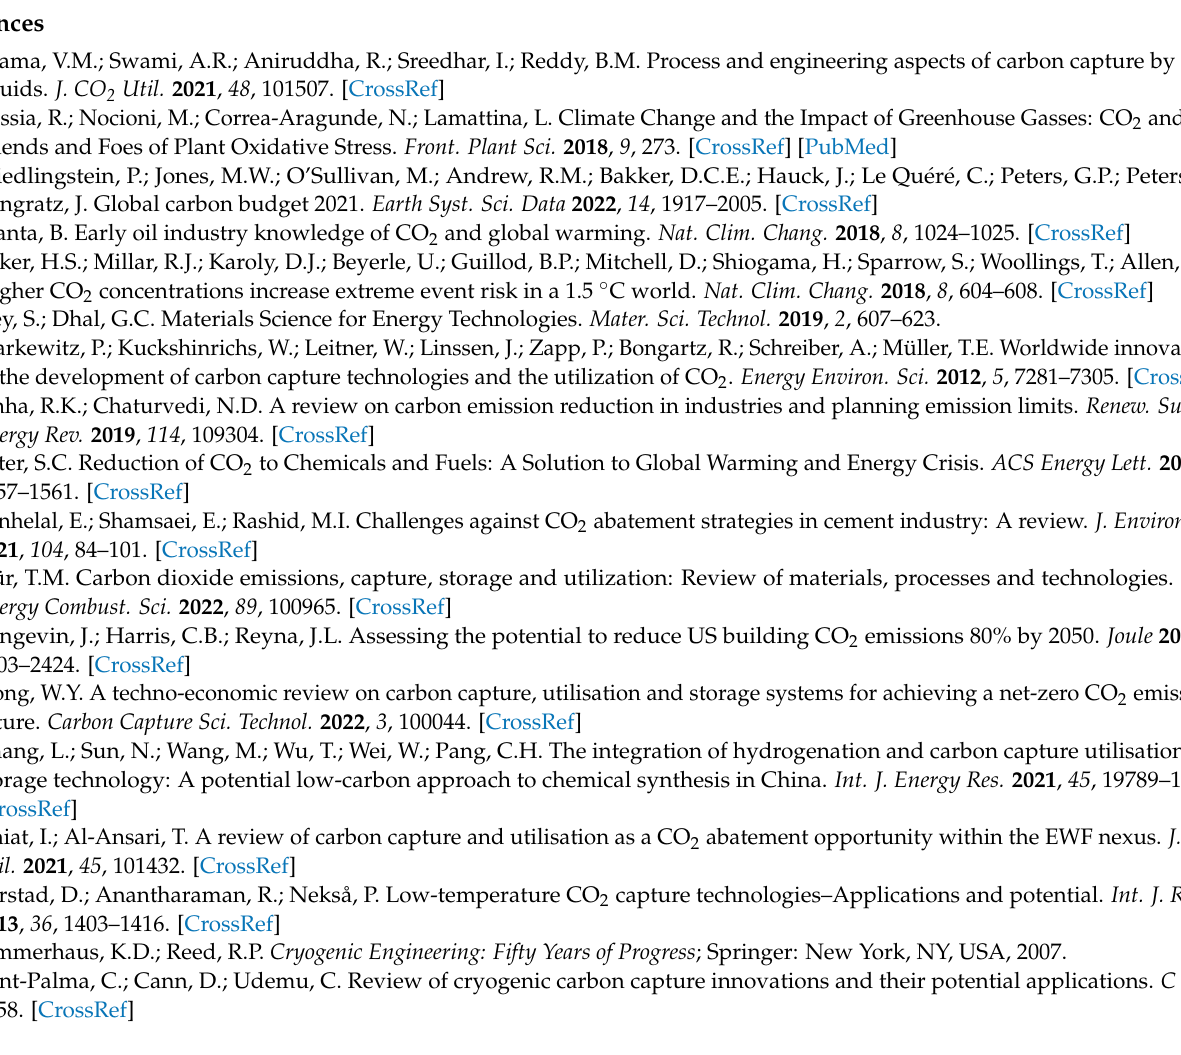
BF4; Figure S2: Sigma potential for TFSI and BF4; Figure S3: Sigma profile for GLY and BF4; Figure S4: Sigma potential for GLY and BF4; Figure S5: Sigma profiles for EMIM, BMIM, BBT, and BF4; Figure S7: Sigma profiles for EMIM, HMIM, BBT, and TFSI; Figure S8: Sigma potentials for EMIM, HMIM, BBT, and TFSI; Figure S9: Sigma profiles for EMIM and BMIM (zoom); Figure S10: Sigma potentials for EMIM and BMIM; Figure S11: Sigma profiles for EMIM, HMIM and TFSI; Figure S12: Sigma potentials for EMIM, HMIM and TFSI; Figure S13: Sigma surface for the chosen cations and anions by employing COSMO-RS. Ref. [80] are cited in the Supplementary